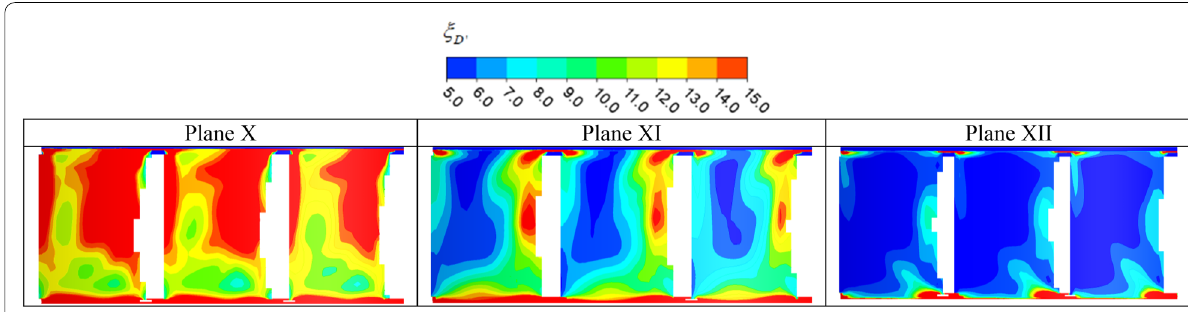
Figure 18 Distributions of entropy loss on radial